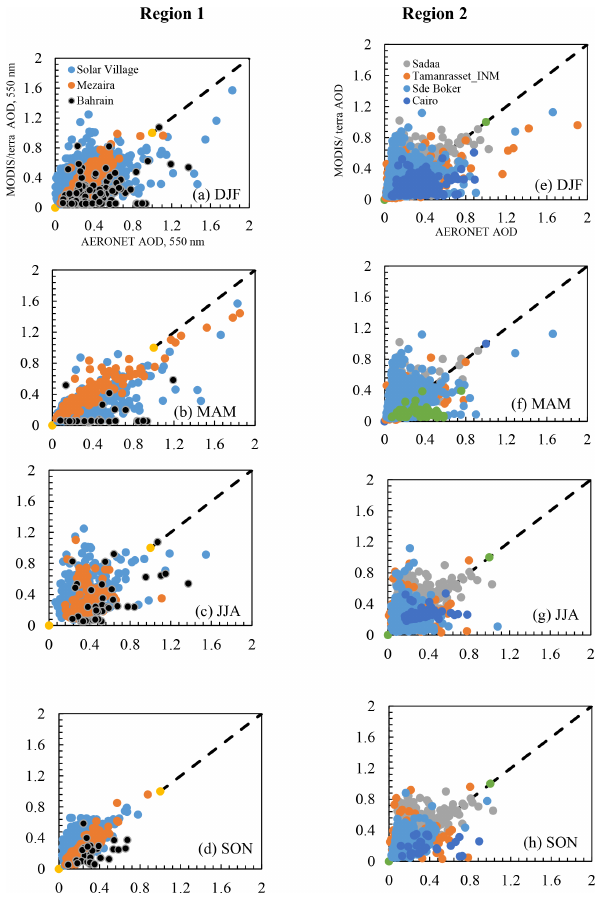
Figure 3. Scatter plot of MODIS AOD versus AERONET AOD based on seasons and aerosols